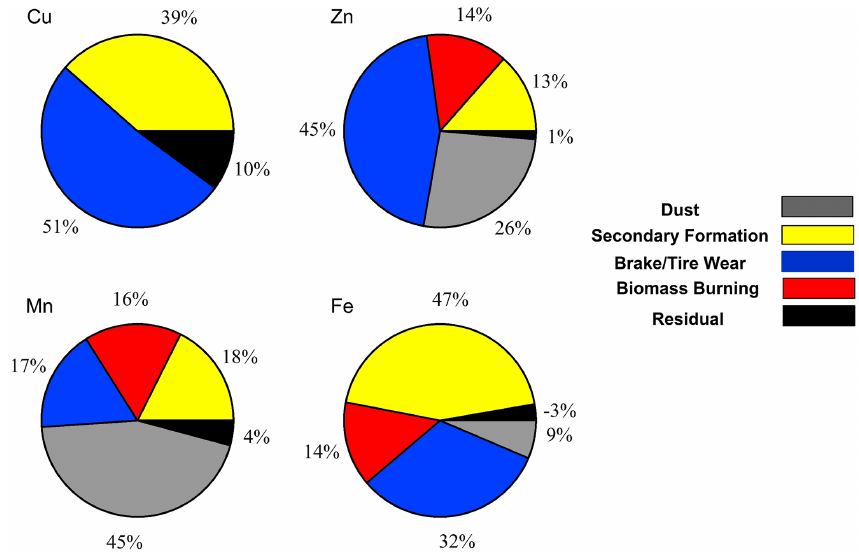
Figure 8. Factor contributions for water-soluble Cu, Zn, Mn, and Fe in PM 2 . 5 based on the PMF